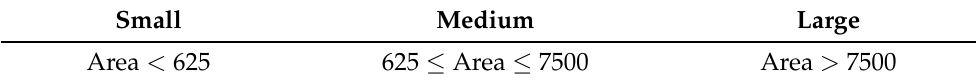
Table 1. Target size classification